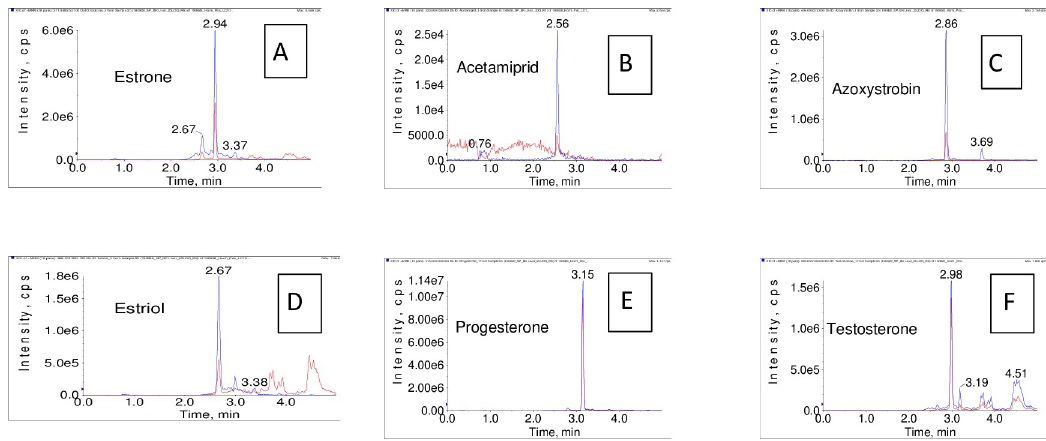
Fig 5. LC-MS/MS chromatograms of a spiked liver sample on LOQ level.